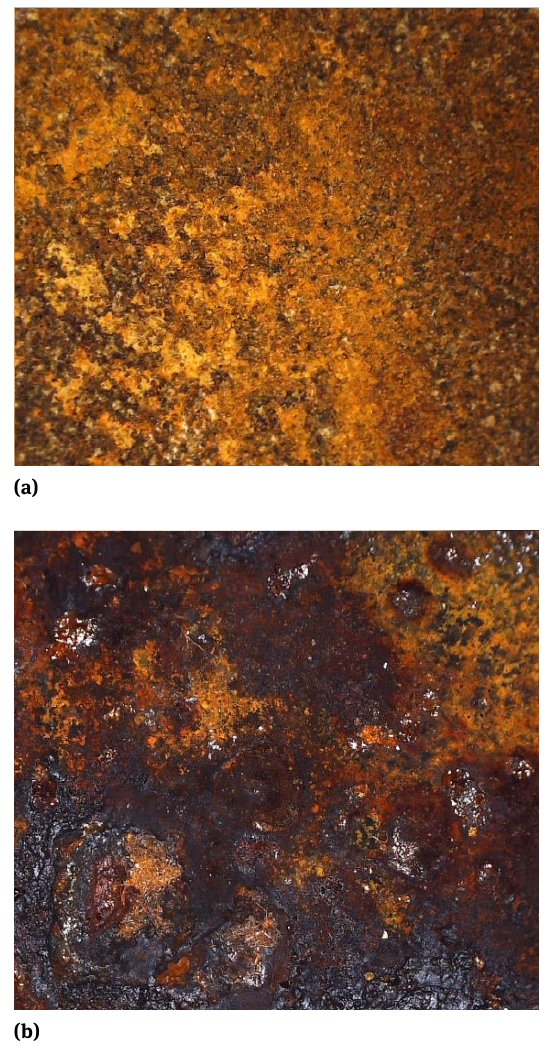
Figure 8: Optical macroscopic image of LCS (a) after corrosion from 0.5 M H 2 SO 4 /TMAV solution and (b) after corrosion from 0.5 M HCl/TMAV solution (mag. ×